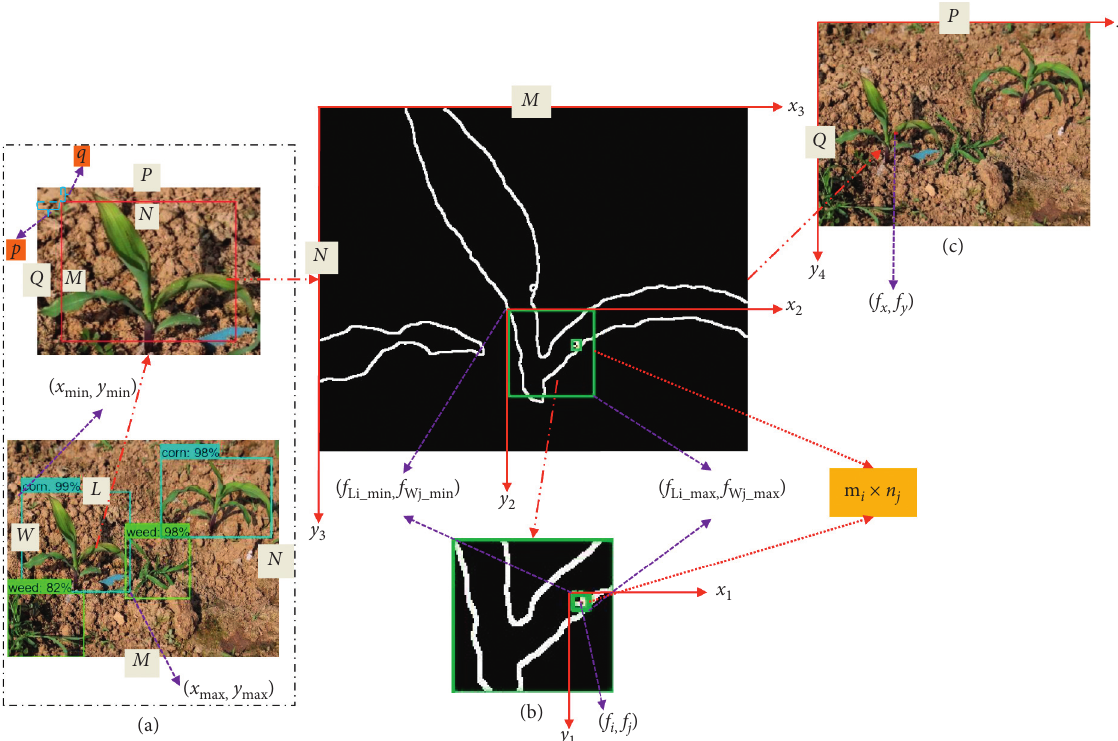
Figure 2: Detailed explanation diagram of each step of the quadratic traversal algorithm.